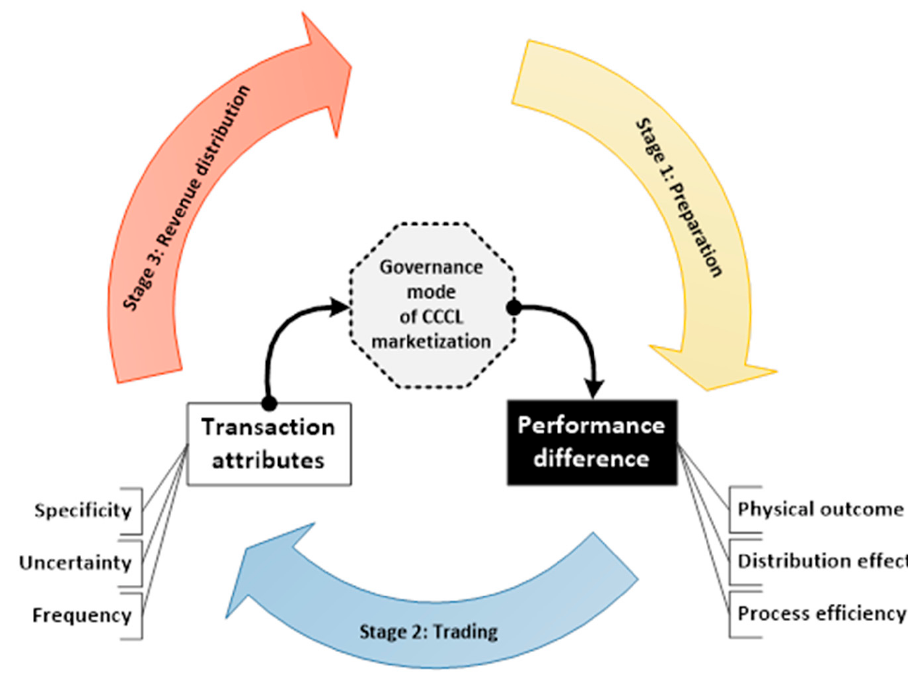
Figure 1. Conceptual framework. CCCL: collective commercial construction land.